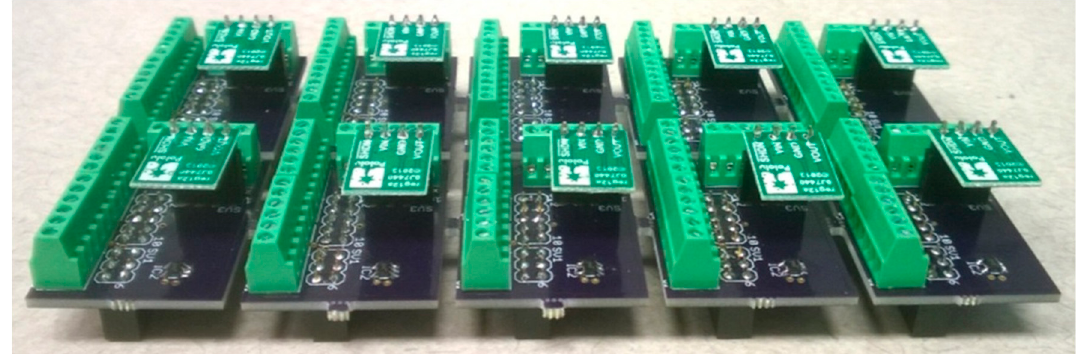
Figure 2. Custom sensor boards for TelosB motes.